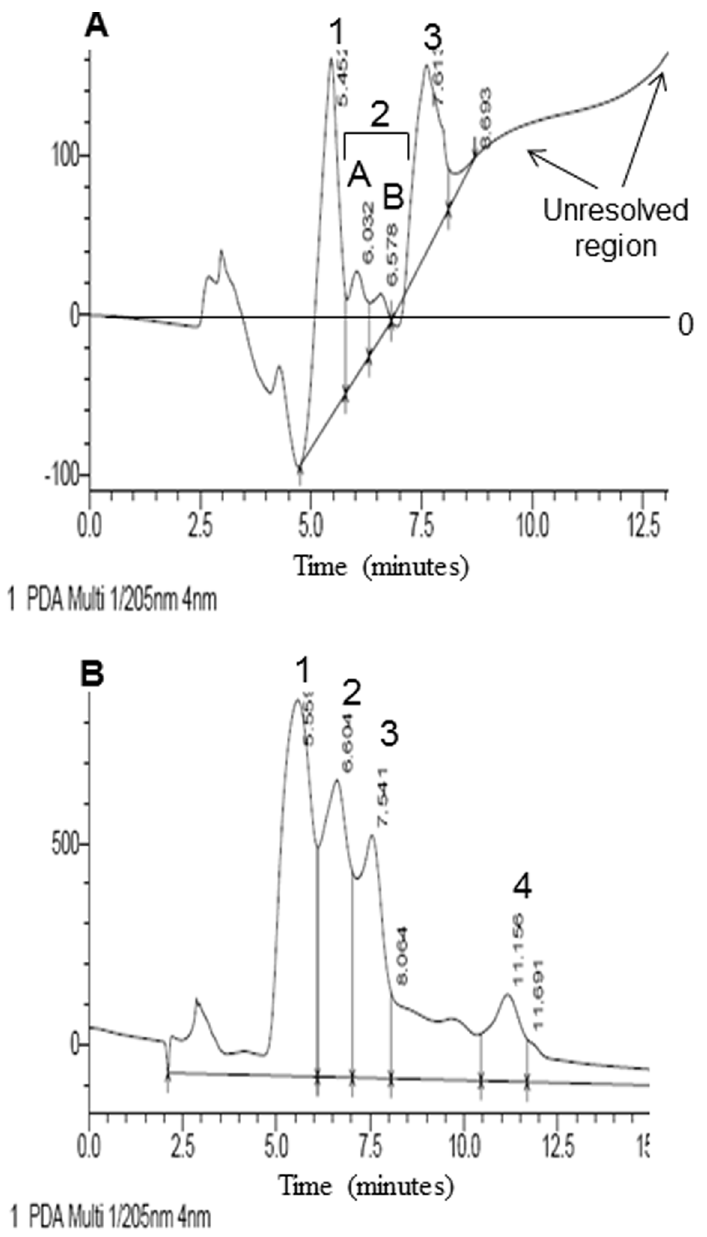
Figure 3. HPLC analysis of end products of ChiA2-treated mucin. The mucin-ChiA2 Reactions were carried as mentioned in the materials and methods section. The end products were analyzed using a 4.6 nm 6 250, 5 m m Zorbax carbohydrate analysis column (Agilent Technologies, Waldbrown, Germany) connected to a Shimadzu Prominence 20A; HPLC system. A . This figure shows the HPLC chromatogram of the end products of ChiA2 treated mucin. The chromatogram shows four distinct peaks and an unresolved region. Peak 1 with retention time 5.4 minutes indicates presence of GlcNAc. Peak 2 indicates presence of (GlcNAc)2 which is divided into two separate peaks: peak 2A and peak 2B. Peak 2A with retention time 6.0 minutes probably is for the b enantiomer and peak 2B with retention time 6.57 minutes is for a enantiomer of (GlcNAc) 2 . Peak 3 with retention time 7.6 minutes indicates the presence of (GlcNAc) 3 . B . This is the HPLC chromatogram of standards of GlcNAc, (GlcNAc) 2 , (GlcNAc) 3 and (GlcNAc) 6 . The chromatogram shows 4 distinct peaks. Peak 1 with retention time 5.5 minutes is for GlcNAc. Peak 2 with retention time 6.6 minutes is for a -(GlcNAc) 2 . Peak 3 with retention time 7.5 minutes is for (GlcNAc) 3 and peak 4 with retention time 11.1 minutes is for (GlcNAc) 6 . doi:10.1371/journal.pone.0103119.g003 (FA) ratio. The FA ratio was calculated by the following formula: FA/cm = volume of fluid accumulation (ml)/intestinal length (cm) [27]. A ratio of greater than 1.0 indicated a strong positive response, while a negative response was defined as FA ratio of less than 0.2.